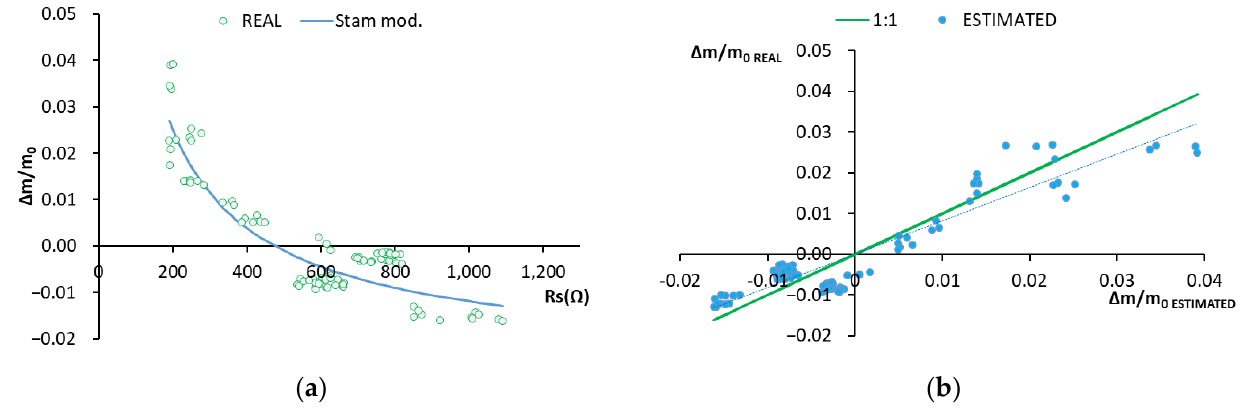
Figure 6. ( a ) Graphical representation of the real validation data and those obtained with the Stam model. Real data: green circles. Stam model: blue line. ( b ) Graphical representation of the real data vs. those estimated. Real data 1:1 line: green line. Stam model: blue dots. Table 4. Statistical parameters to evaluate the validation of the estimation model of humidity variation in hardened concrete. Line Slope RMSE R 2 Real vs. Estimated Stam mod. 0.0053 0.818 0.835